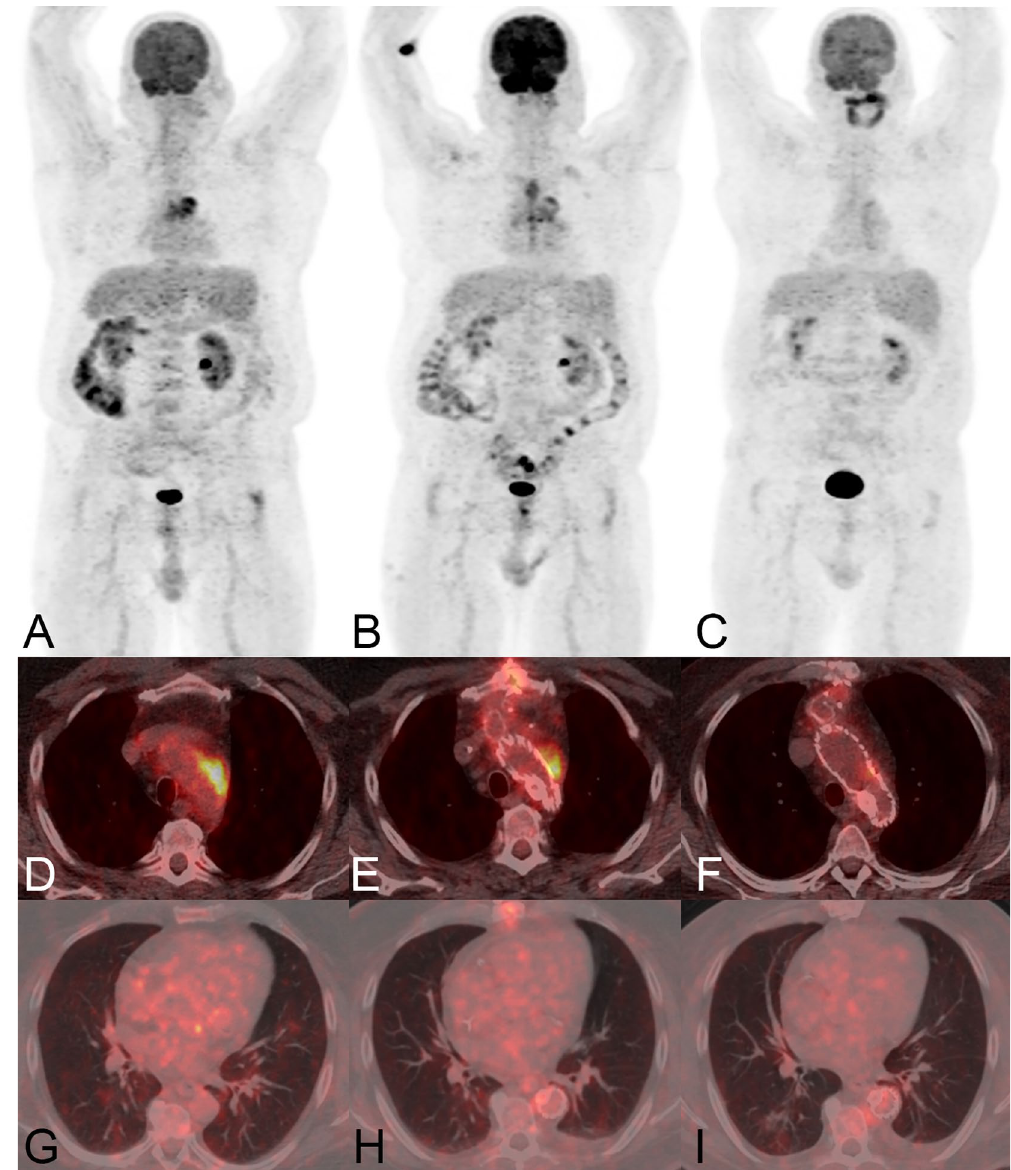
Figure 3. A 70-year old male patient (patient 04 in Tables 1, 2 and 3) presented with chest pain and signs for infection (C-reactive protein 122 mg/L). The initial PET/CT examination showed strongly increased FDG- uptake in the wall of an aortic arch aneurysm and no other infectious foci. Both PET/CT readers suspected a infective native aneurysm; which was clinically confirmed ( Streptococcus agalactiae in blood cultures). At first PET/CT follow-up (ongoing antimicrobial therapy, after thoracic endovascular repair with a Conformable GORE TAG Thoracic Endoprosthesis and debranching) a strong residual focal FDG-uptake was detected adjacent to the graft, in line with a secondary vascular graft infection. The second PET/CT follow-up (ongoing antimicrobial therapy), showed only very faintly increased FDG-uptake adjacent to the graft. However, a new pneumonia in the right lower lobe was incidentally detected. The patient died 60 days after the last PET/CT due to a gastrointestinal bleeding not related to the thoracic infective native aortic aneurysm. Note : Panels A-C show maximum intensity reconstructions of PET; Panels D-I show fused PET/CT images. Abbreviations: PET: positron emission tomography; CT: computed tomography; FDG: